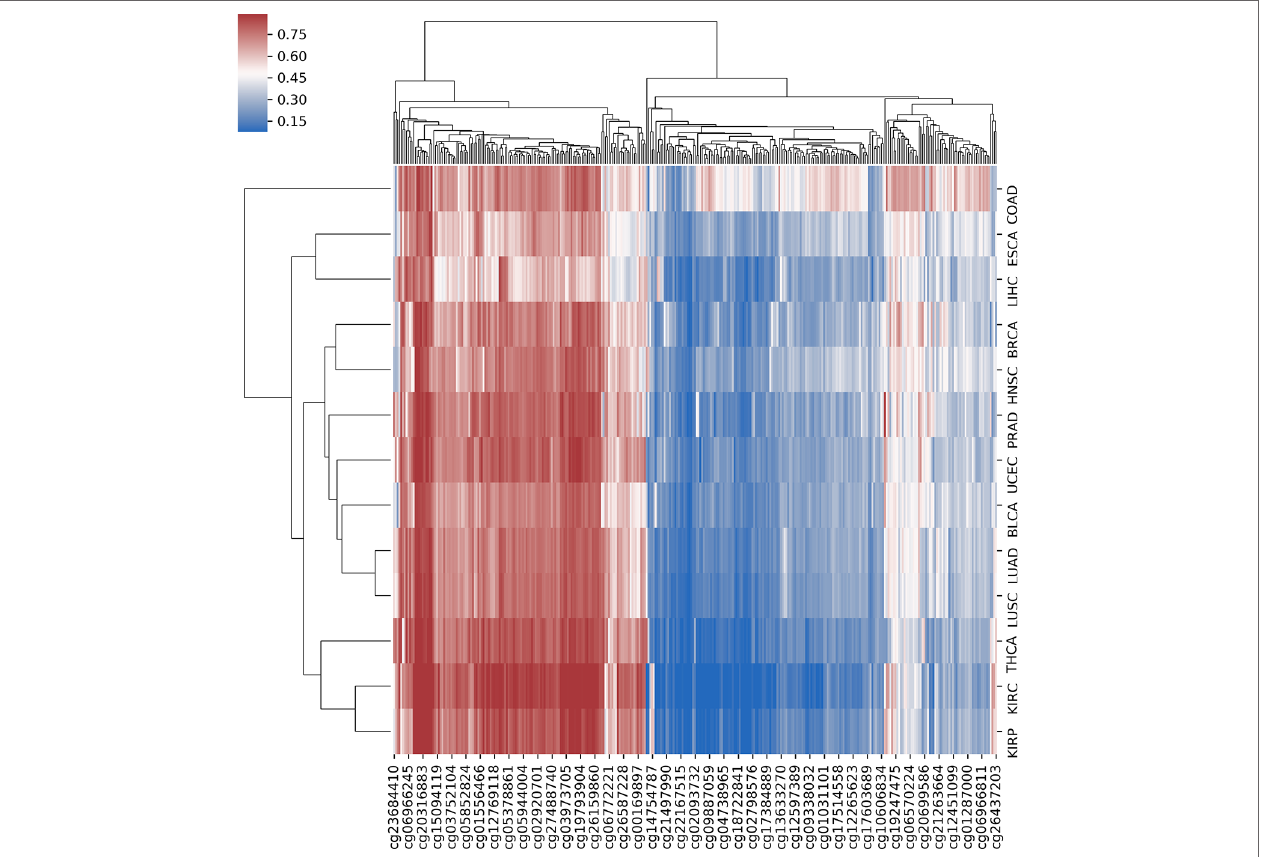
FIGURE 4 | The hierarchical clustering with heat map using all predefined pan-cancer differential methylation sites in 13